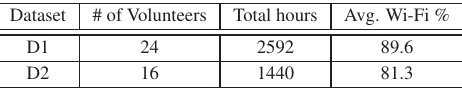
Table 2: Dataset